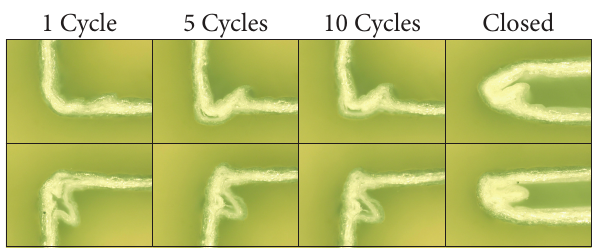
Figure 15. Cyclic behavior for Tyvek ® . Notice the similarity to the characteristics of the